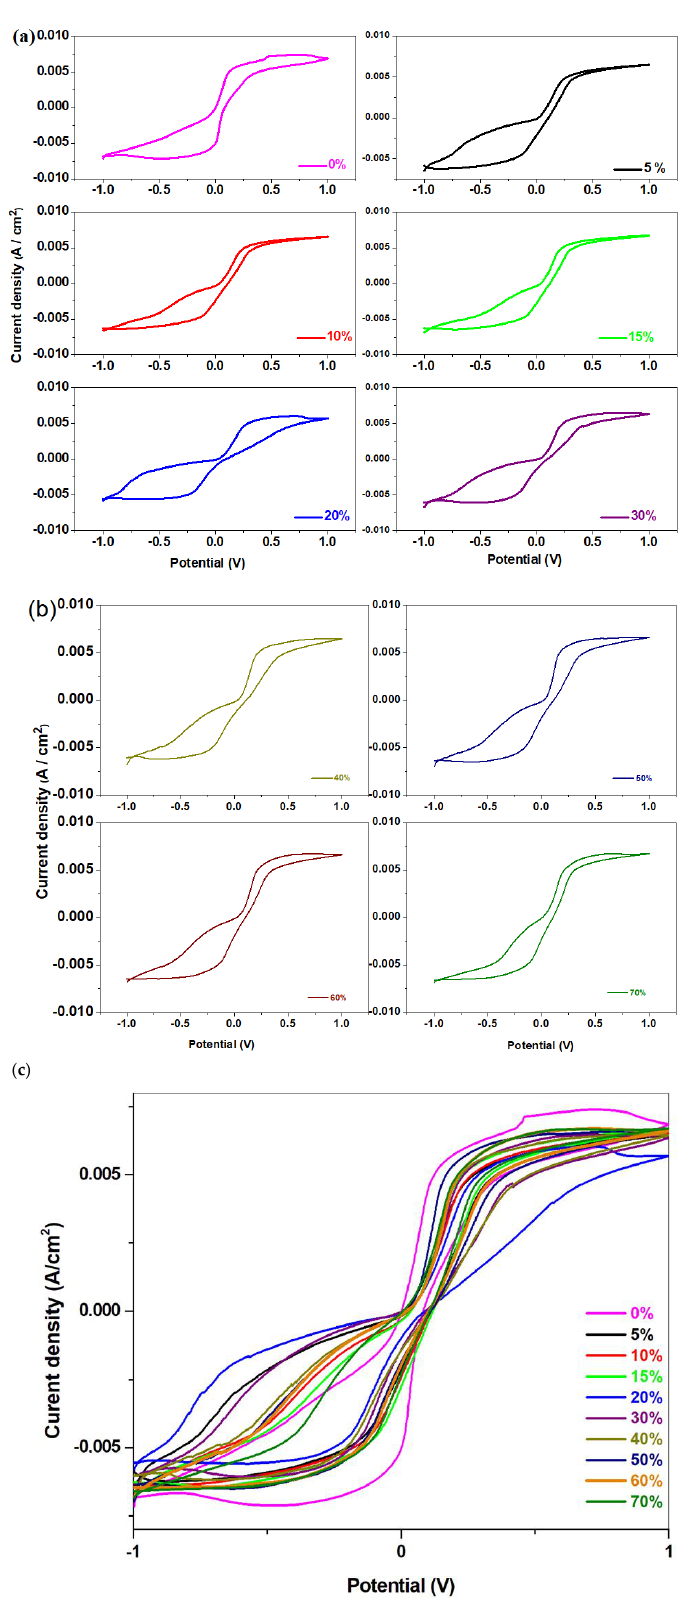
Figure 6. Cyclic voltammogram of the recycled glass system with the xNaH 2 PO 4 ·5MnO 2 ·(95 − x)[4PbO 2 ·Pb] composition where ( a ) x = 0 – 30 mol% NaH 2 PO 4 , ( b ) x = 40 – 70 mol% NaH 2 PO 4 and ( c ) x = 0 – 70 mol% NaH 2 PO 4 .